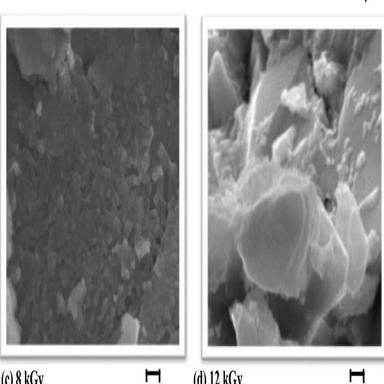
SEM images of unexposed and exposed samples of STS ChGA: (a) 0 kGy, (b) 4 kGy, (c) 8 kGy, (d) 12 kGy.